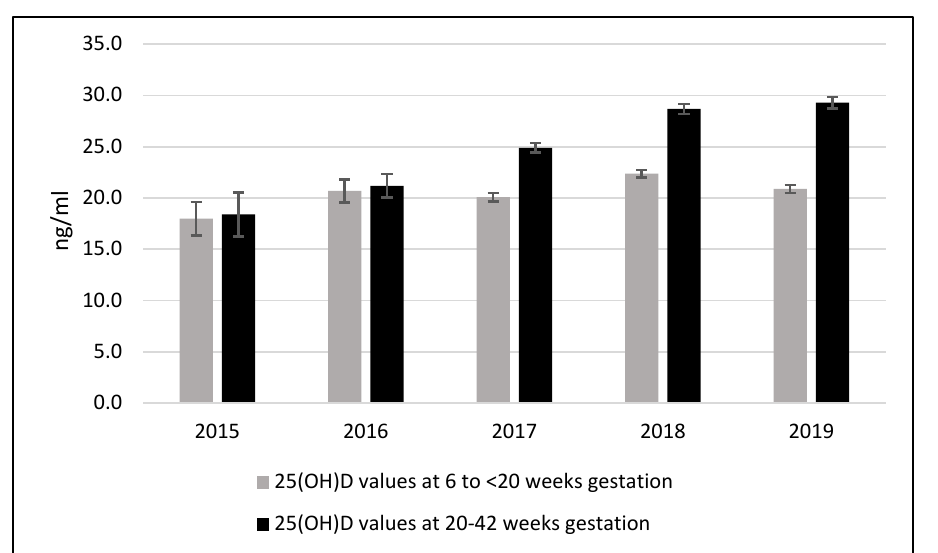
Figure 1. 25(OH) vitamin D status pre-supplementation (2015–2016) and post-supplementation (2017–2019) among prenatal women 20+ weeks gestation, Yukon Kuskokwim Delta region. (Deficient <12 ng/mL; Insufficient ≥ 12 ng/mL and <20 ng/mL; Sufficient ≥ 20 ng/mL).